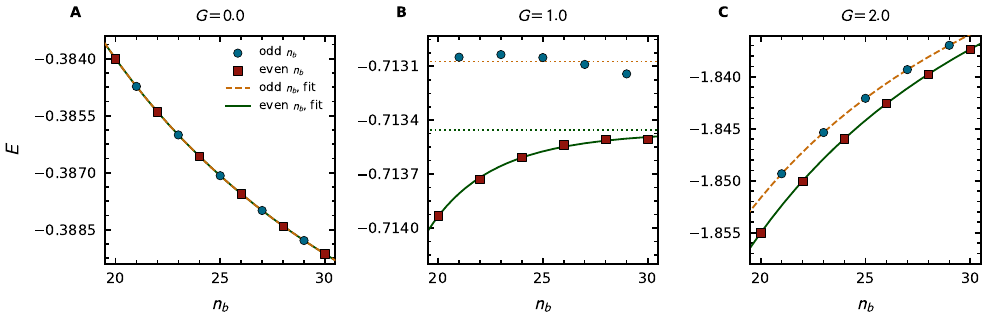
Figure 9: Extrapolation of effective interaction results in the presence of a mag- netic impurity for 1 ↑ + 1 ↓ at g = − 2.0. (A) Convergence from above without the impurity. (B) Weak cutoff dependence in the vicinity of the crossover point, asymp- totic values are indicated by dotted lines. (C) Convergence from below when G is